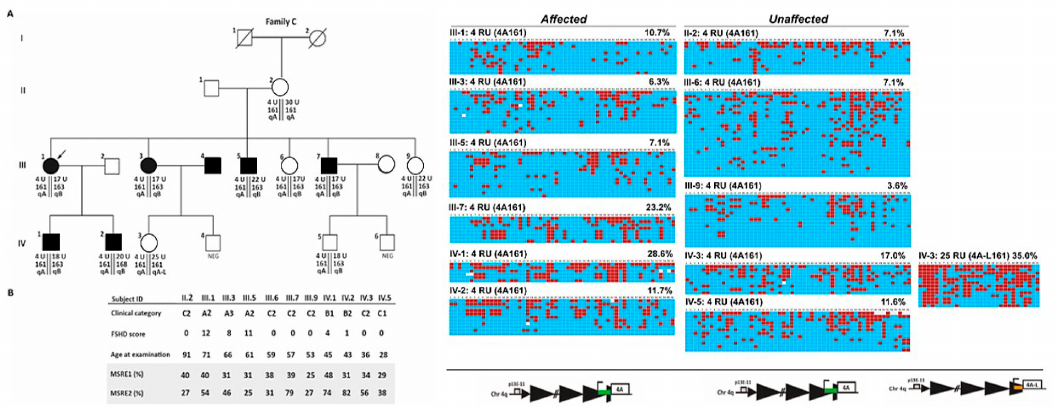
Figure 5. Analysis of the D4Z4 methylation status in Family C. ( A ) Pedigree of family C. The genetic profile ( A ) or the clinical and epigenetic features ( B ) of each individual are reported. Filled symbols represent affected people. ( C ) Genomic DNAs from the selected individuals were analyzed using the 4qA or 4qA-L sodium bisulfite sequencing (BSS) assay. The percent DNA methylation for the Q1 is indicated. Red boxes indicate methylated CpGs, blue boxes indicate unmethylated CpGs, and white boxes indicate no CpG at the expected site.